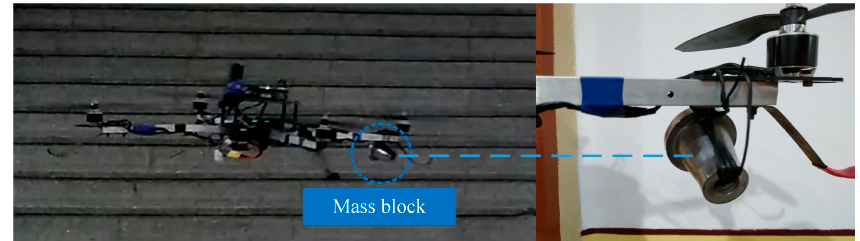
Figure 19. A mass block hung from the right hand front corner is used as the eccentric mass.